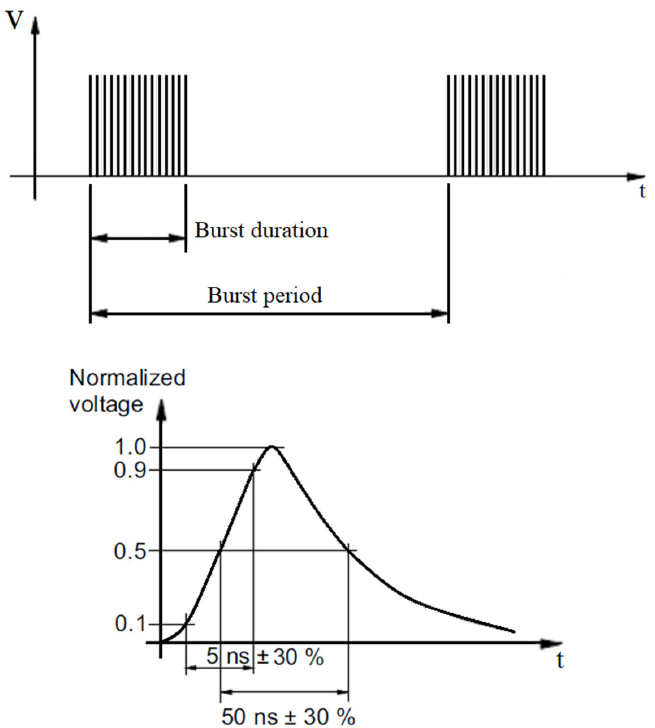
Figure 4. Burst train pulses and single-pulse waveform (50 Ω load case).